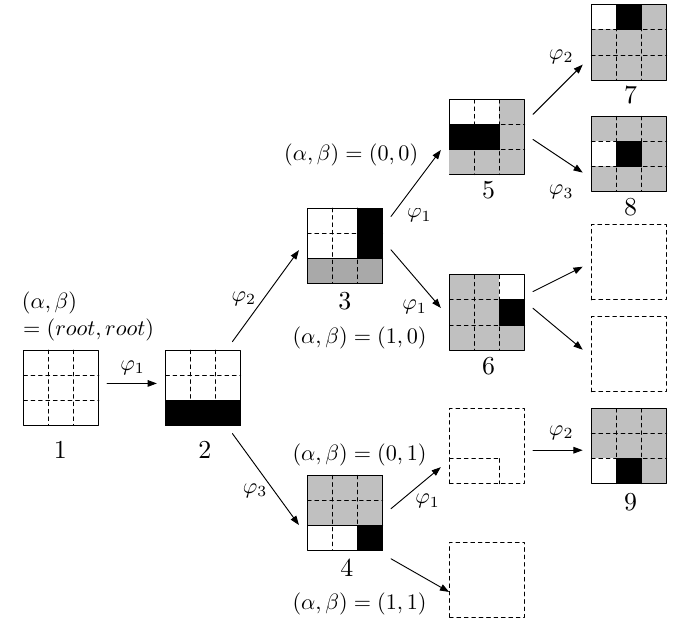
Figure 3. Appearance of constructing the basis images of size 3 × 3.